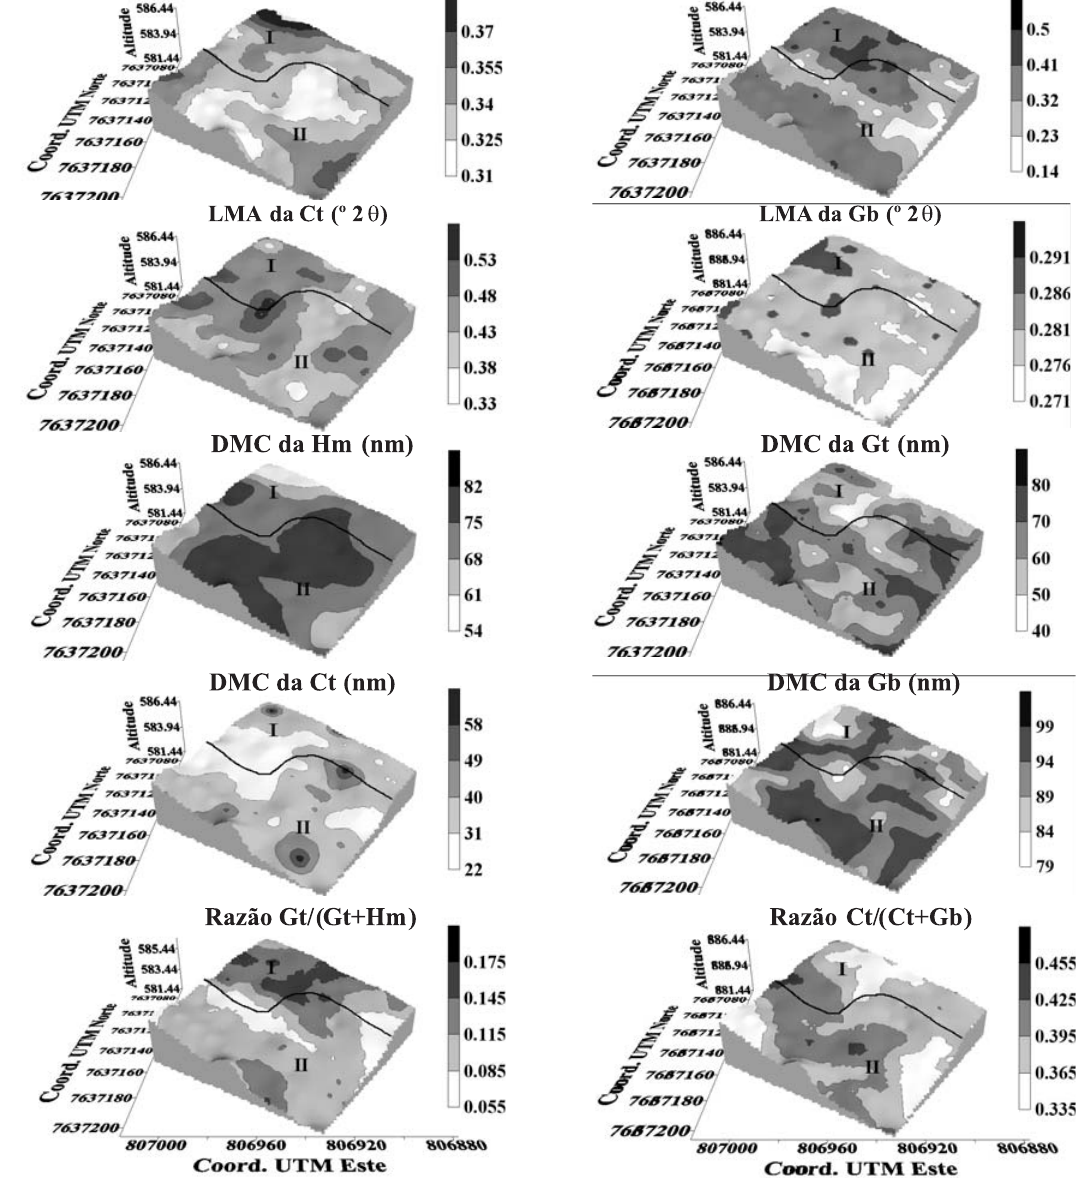
Figura 3. Mapas do padrão espacial dos atributos: largura à meia altura (LMA), diâmetro médio do cristal (DMC) dos minerais hematita (Hm), goethita (Gt), caulinita (Ct) e gibbsita (Gb) e razões Gt/(Gt+Hm) e Ct/(Ct+Gb). Coord.=